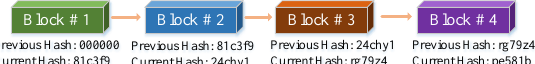
Figure 9. Nodes in WSNs are linked together in the blockchain under normal